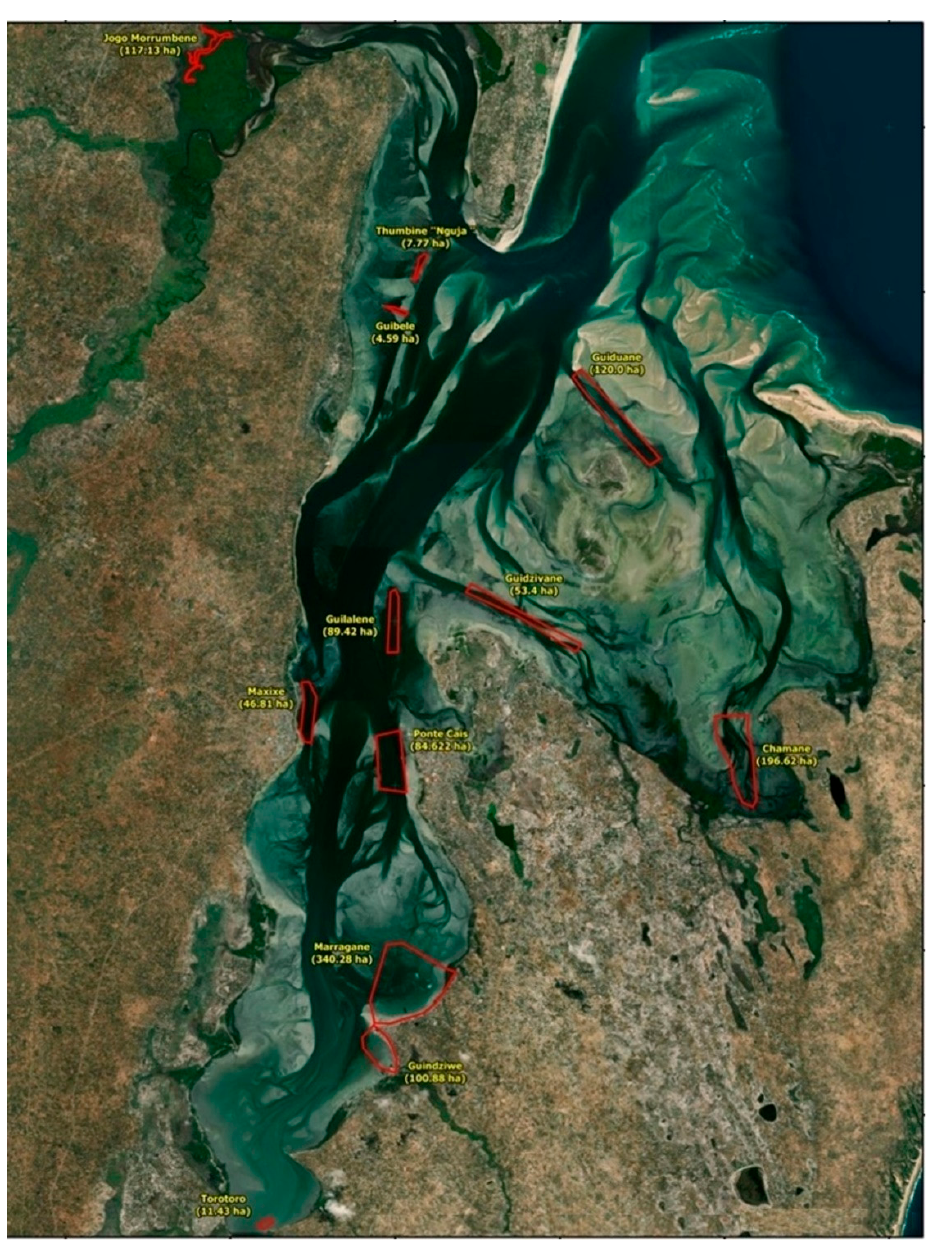
Figure 5. Marine areas under community protection (or LMMAs) within Inhambane Bay, outlined in red. Source: Ocean Revolution Mozambique (ORM), 2021.